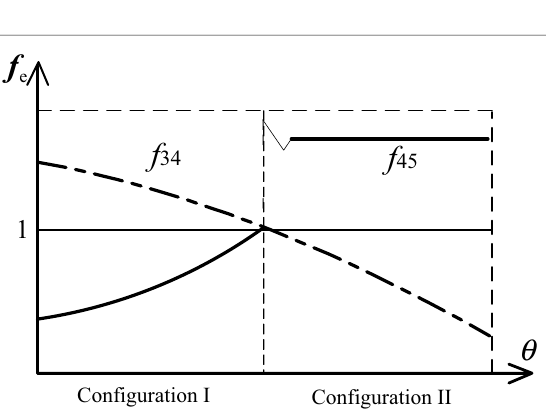
Figure 15 Equivalent resistance gradient sketch of